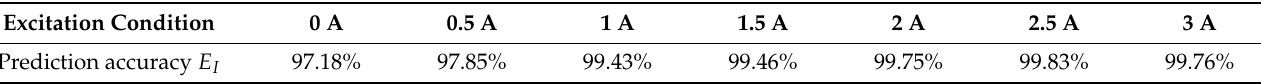
Table 2. Relative approximation accuracy of magnetorheological suspension inverse